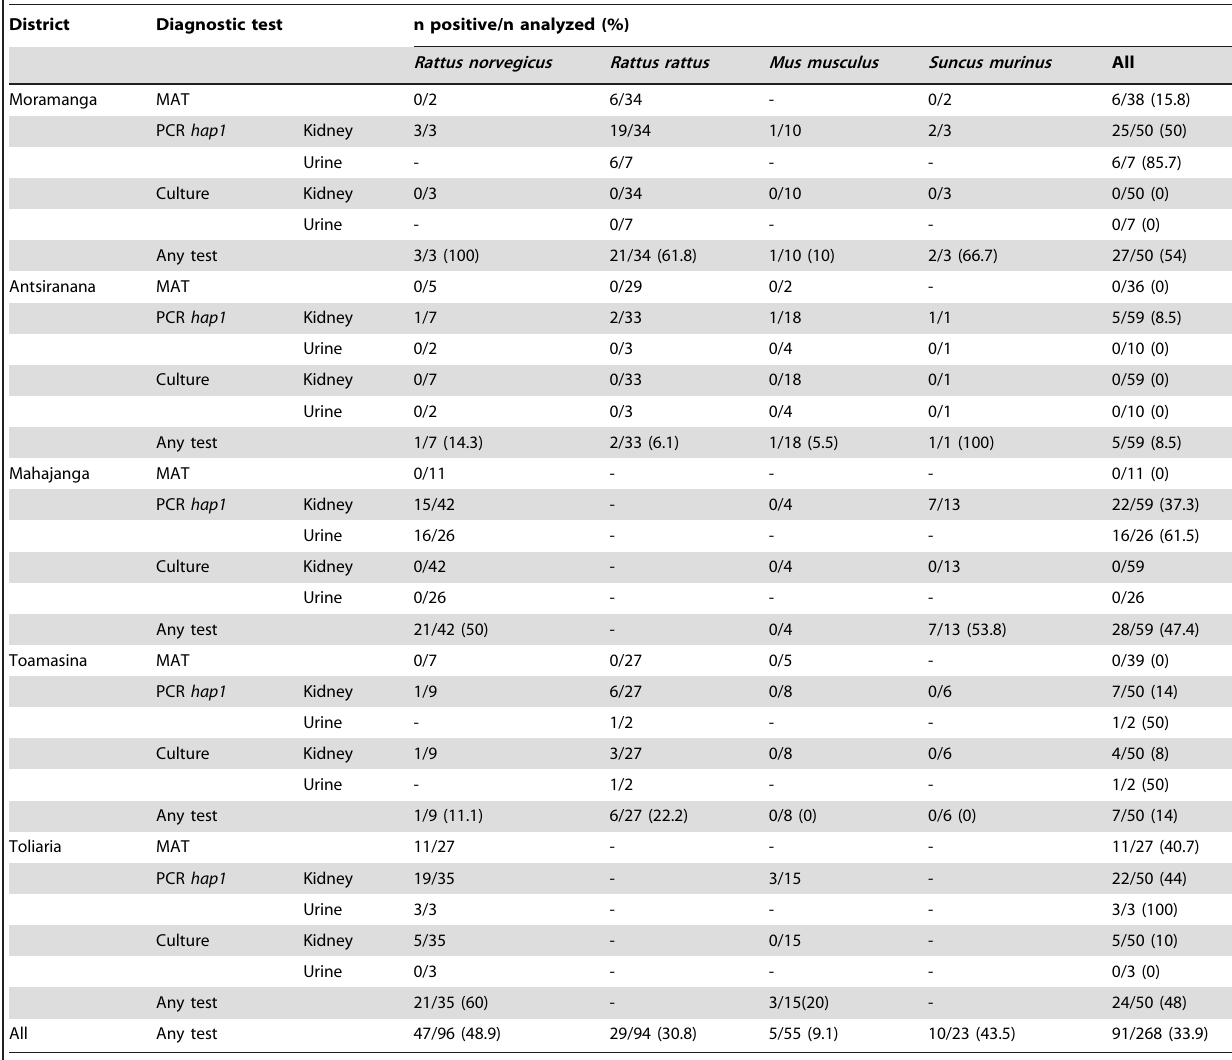
Table 2. Prevalence of pathogenic Leptospira carriage in small mammals by site and species.